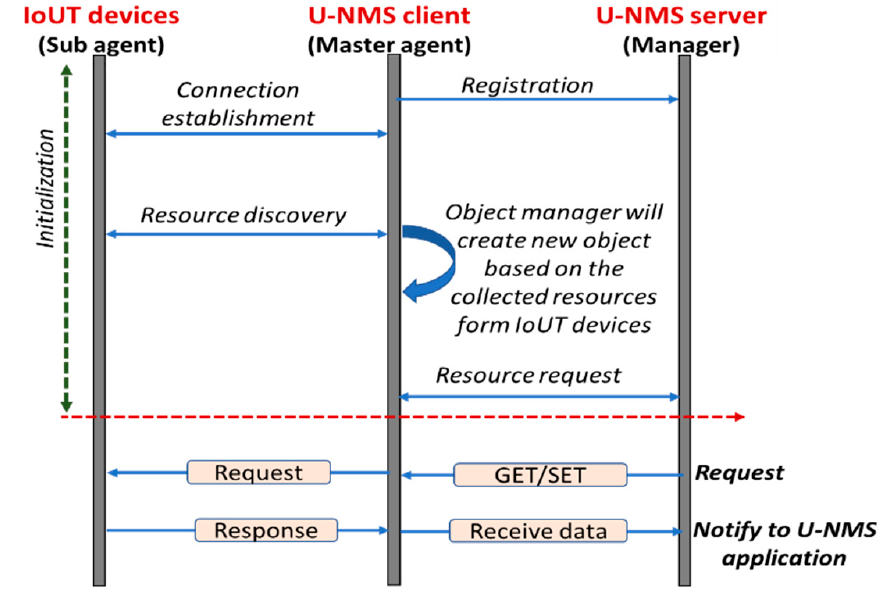
Figure 13. Sequence diagram for creating GET/SET operation in U-NMS.